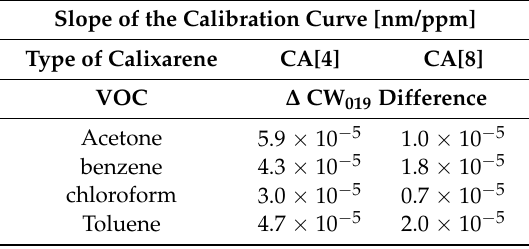
Table 2. Sensitivity of CA[4] and CA[8] to individual VOCs.